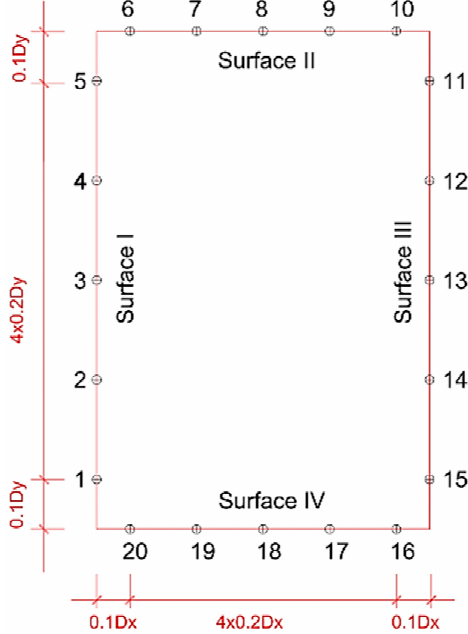
Figure 1. Pressure taps on CAARC building faces.